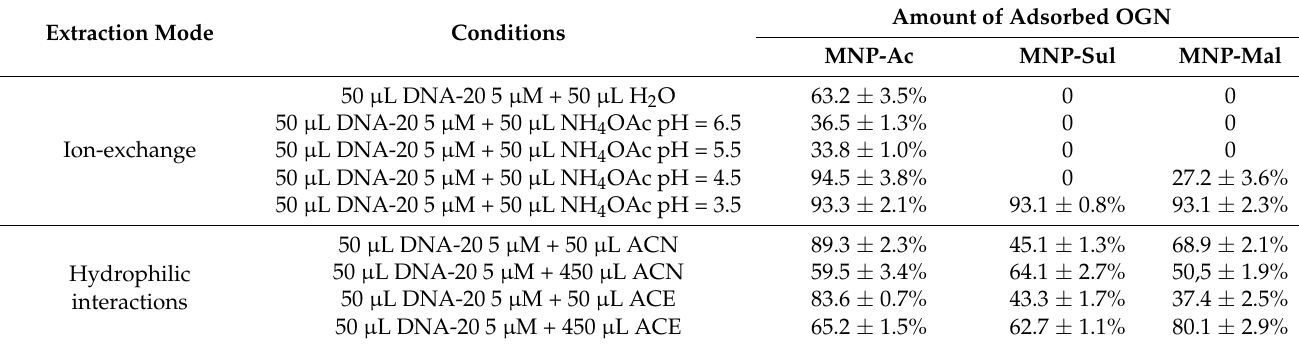
Table 2. Amounts of DNA-20 adsorbed on tested MNPs in different modes. Abbreviations: OGN—oligonucleotide; ACN—acetonitrile;